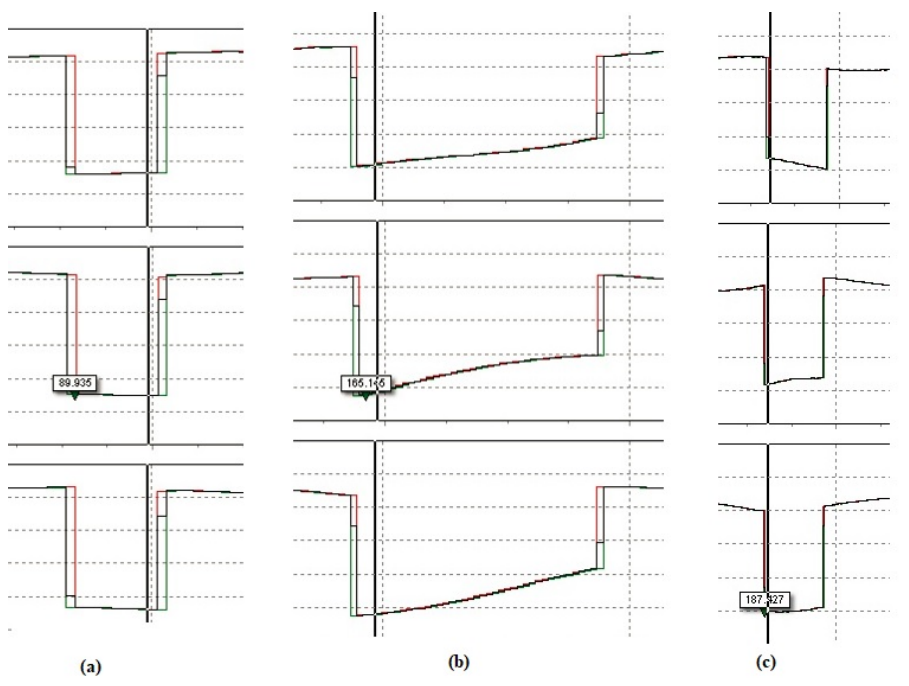
Figure 16. Grid connected to induction motor under loaded conditions with a sag of ( a ) 40%, ( b ) 70%, and ( c ) 80%. Table 3. Induction motor under loaded conditions [neutral not connected].